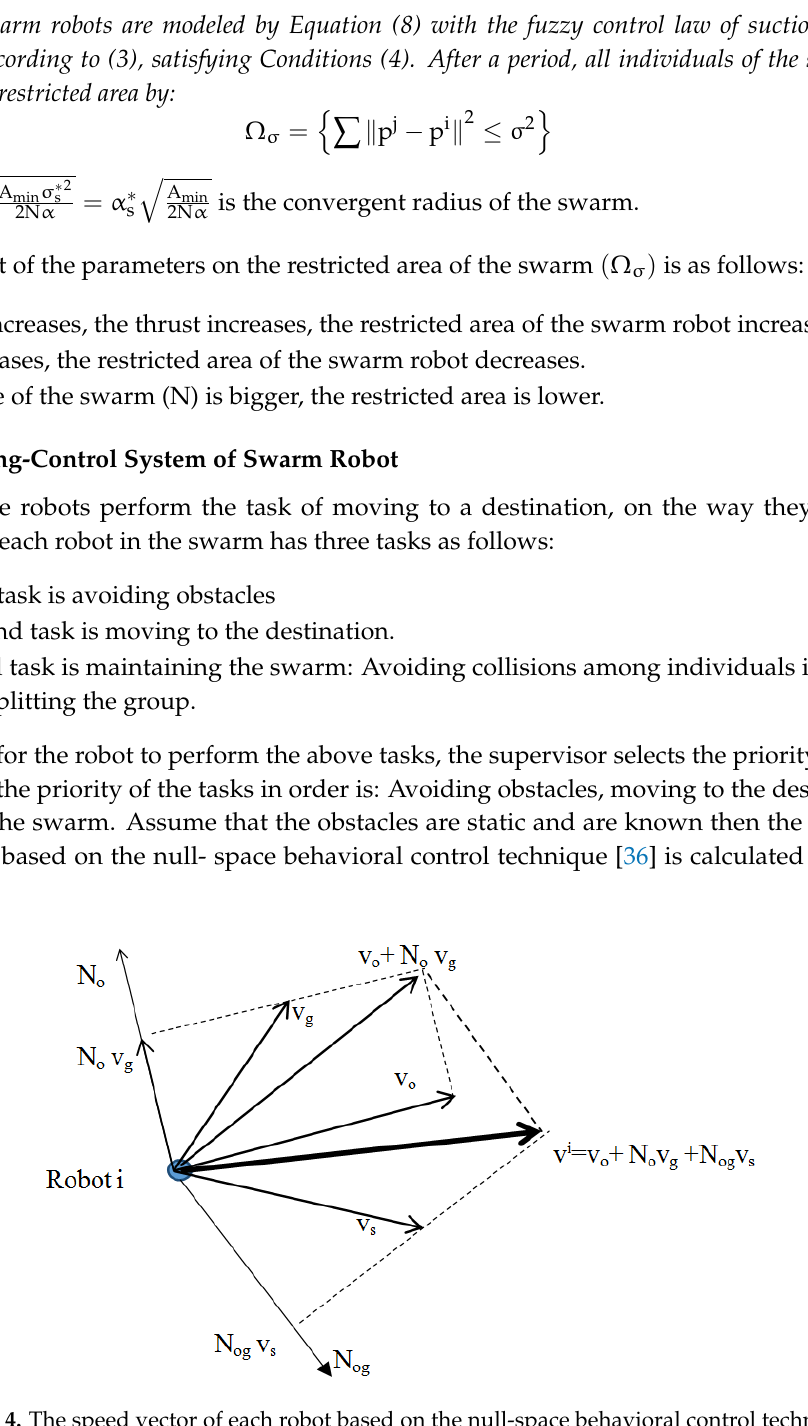
Figure 4. The speed vector of each robot based on the null-space behavioral control technique.